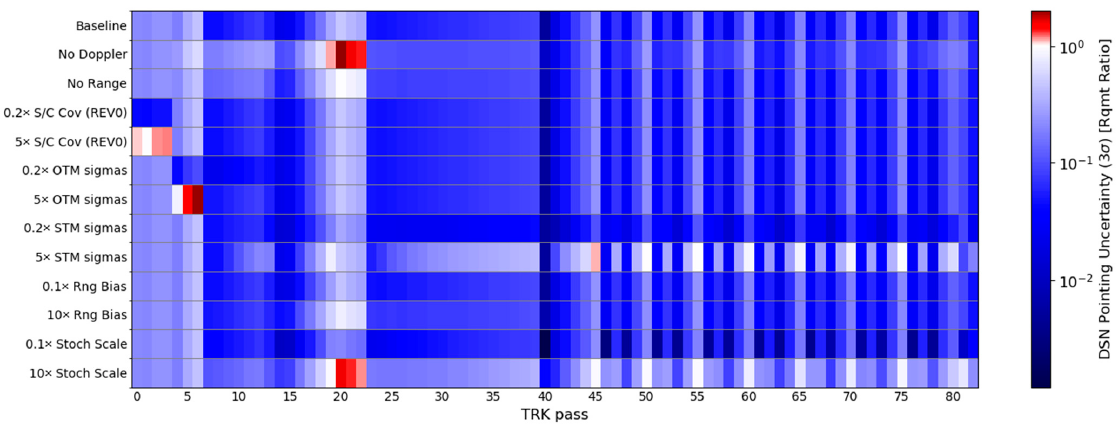
Figure 17. Full mission DSN pointing requirement ratio between the expected uncertainty and the requirement, for each tracking (TRK) pass, with respect to each relevant sensitivity case.